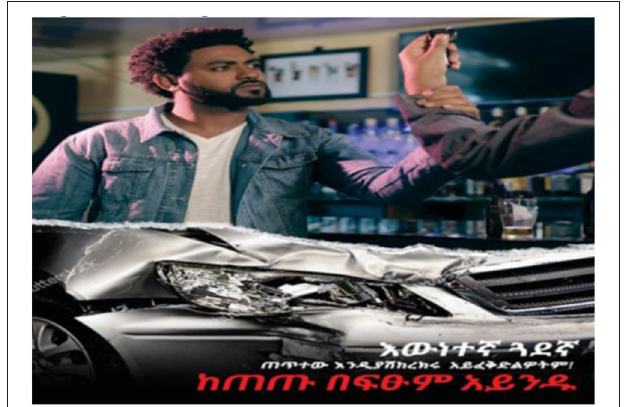
FIGURE 1 | Image from PSA “Celebrate”.